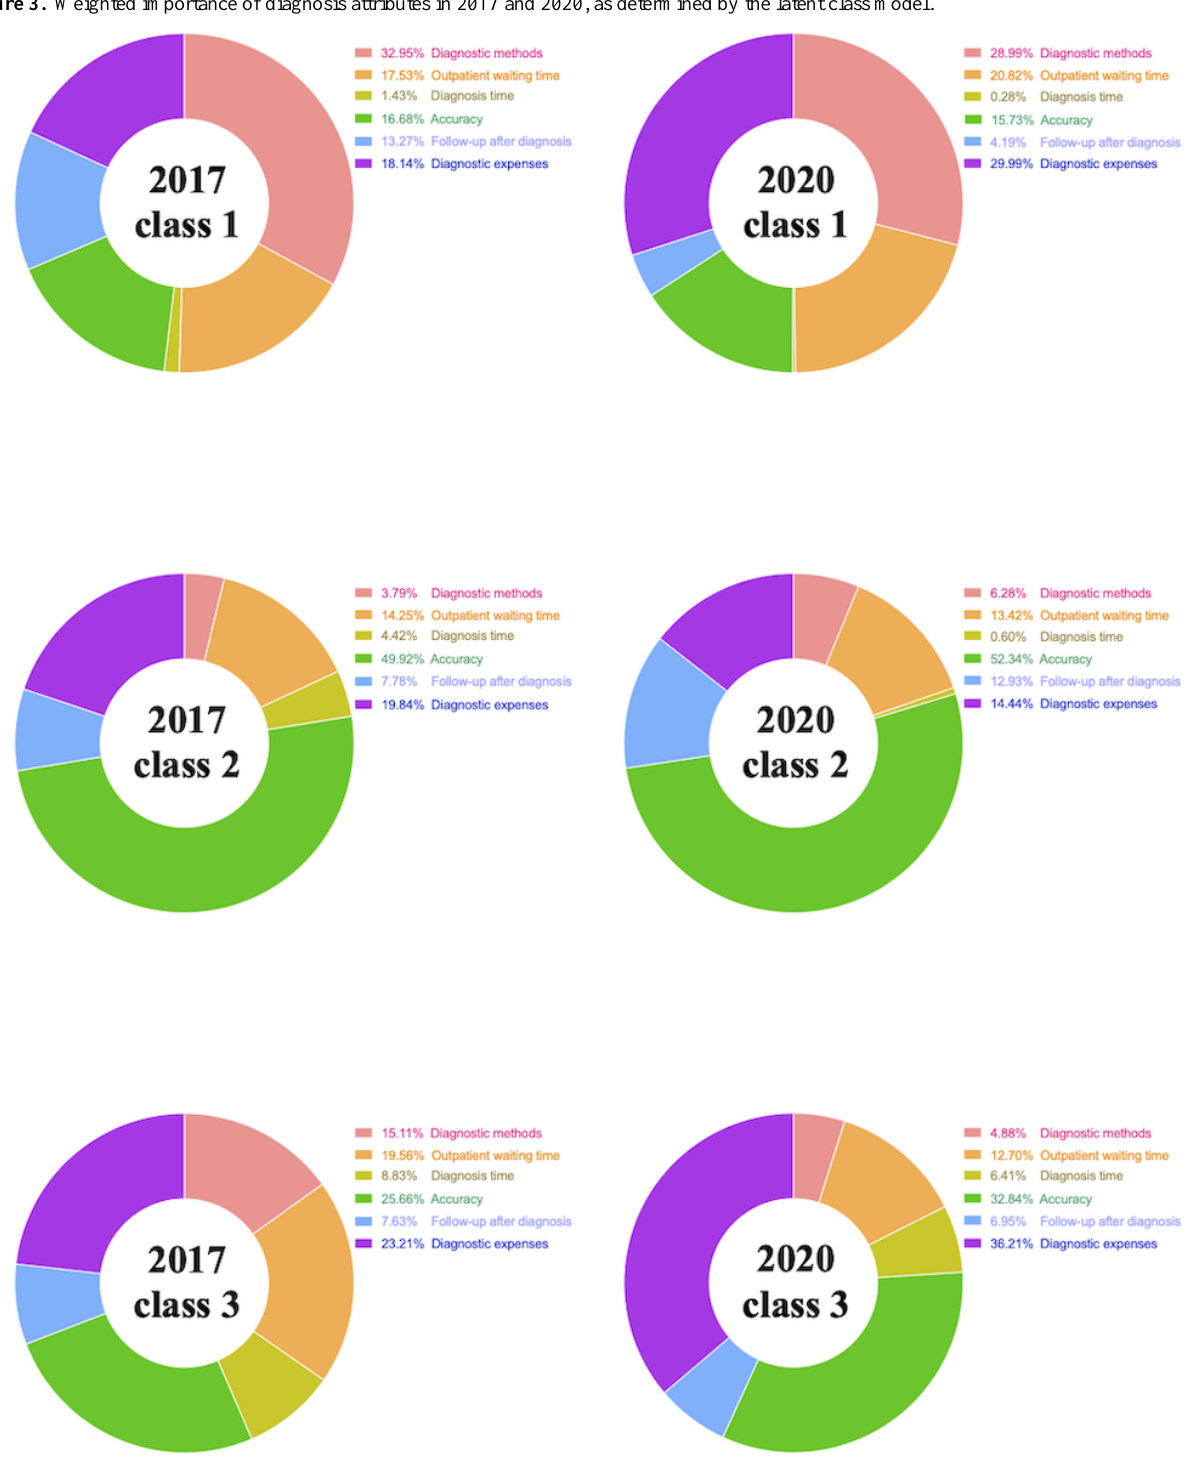
Figure 3. Weighted importance of diagnosis attributes in 2017 and 2020, as determined by the latent class